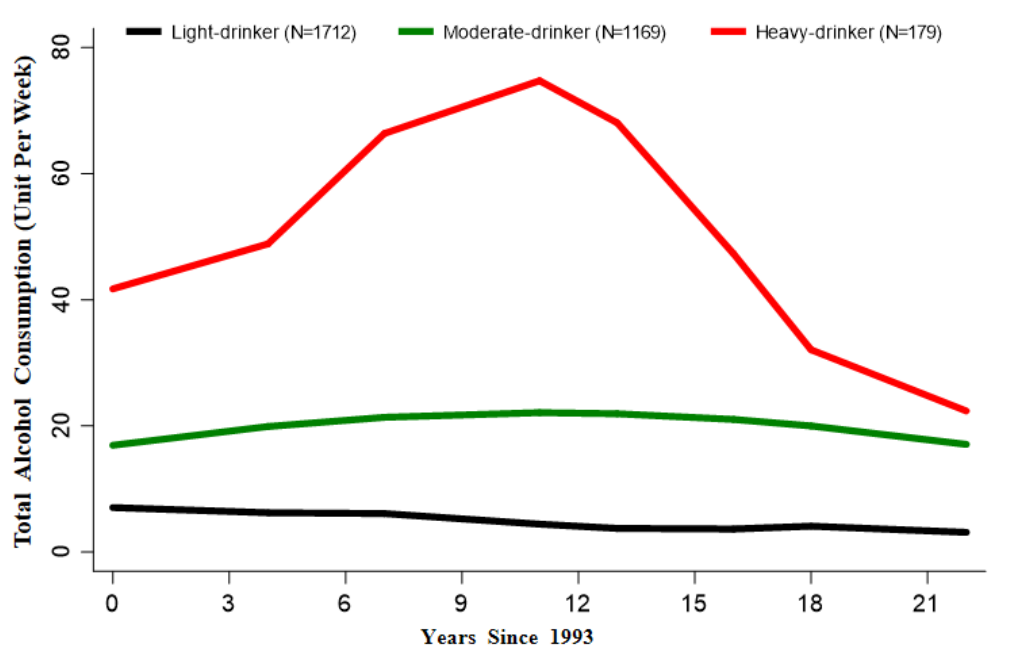
Figure 1. Trajectories from 1993 to 2015 for alcohol consumption.